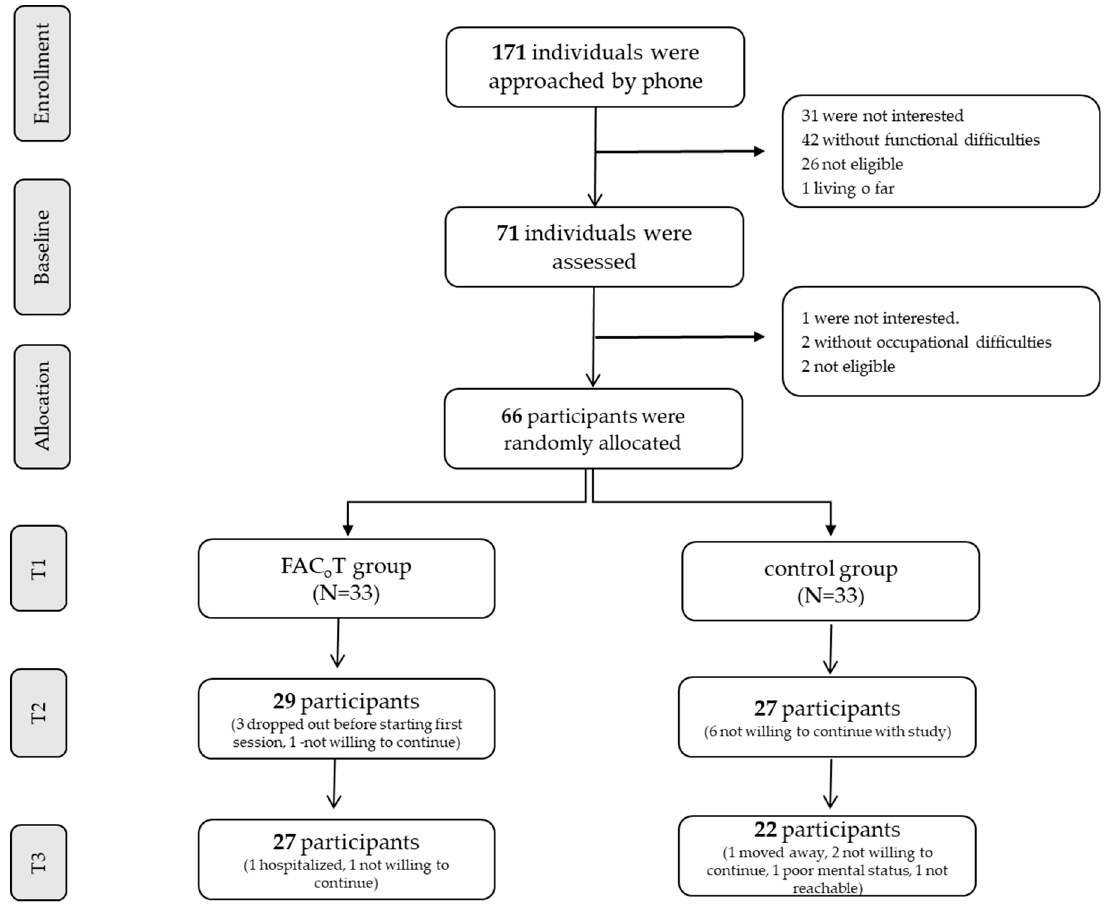
Figure 1. CONSORT flow diagram (Note: at T2 and T3, all 33 cases in each group were analyzed using intention-to-treat analysis).